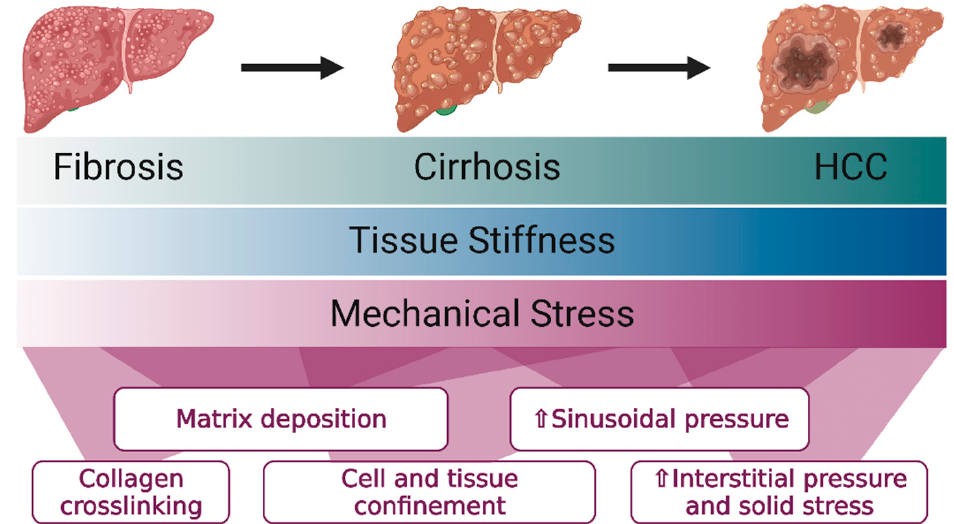
Figure 1. Tissue stiffness and mechanical stress compound over time as fibrosis progresses to cirrhosis, even before developing HCC.